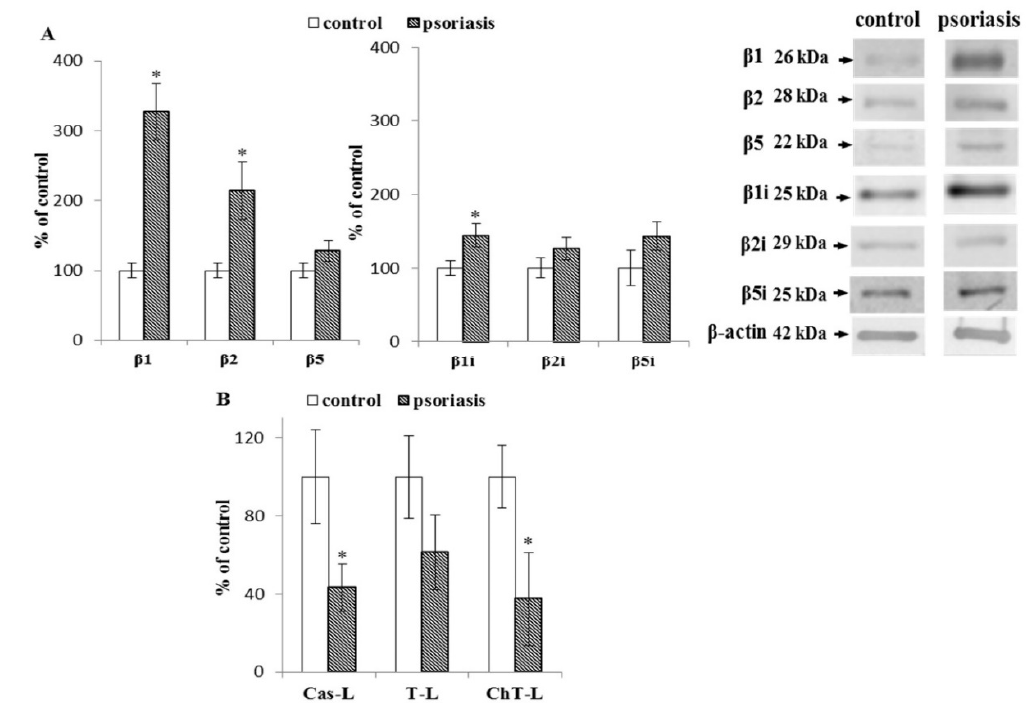
Figure 1. ( A ) Expression of the constitutive proteasome ( β 1, β 2, β 5) and immunoproteasome ( β 1i, β 2i, β 5i) subunits in lymphocytes from patients with psoriasis ( n = 6), in comparison to healthy subjects (control), ( n = 6). ( B ) Caspase-like (Cas-L), trypsin-like (T-L), and chymotrypsin-like (ChT-L) activities of the proteasomes in lymphocytes from patients with psoriasis ( n = 16) and healthy subjects (control), ( n = 12). Values in ( A ) and ( B ) are expressed as a percentage of control. ∗ —statistical significance at p < 0.05 vs. control.